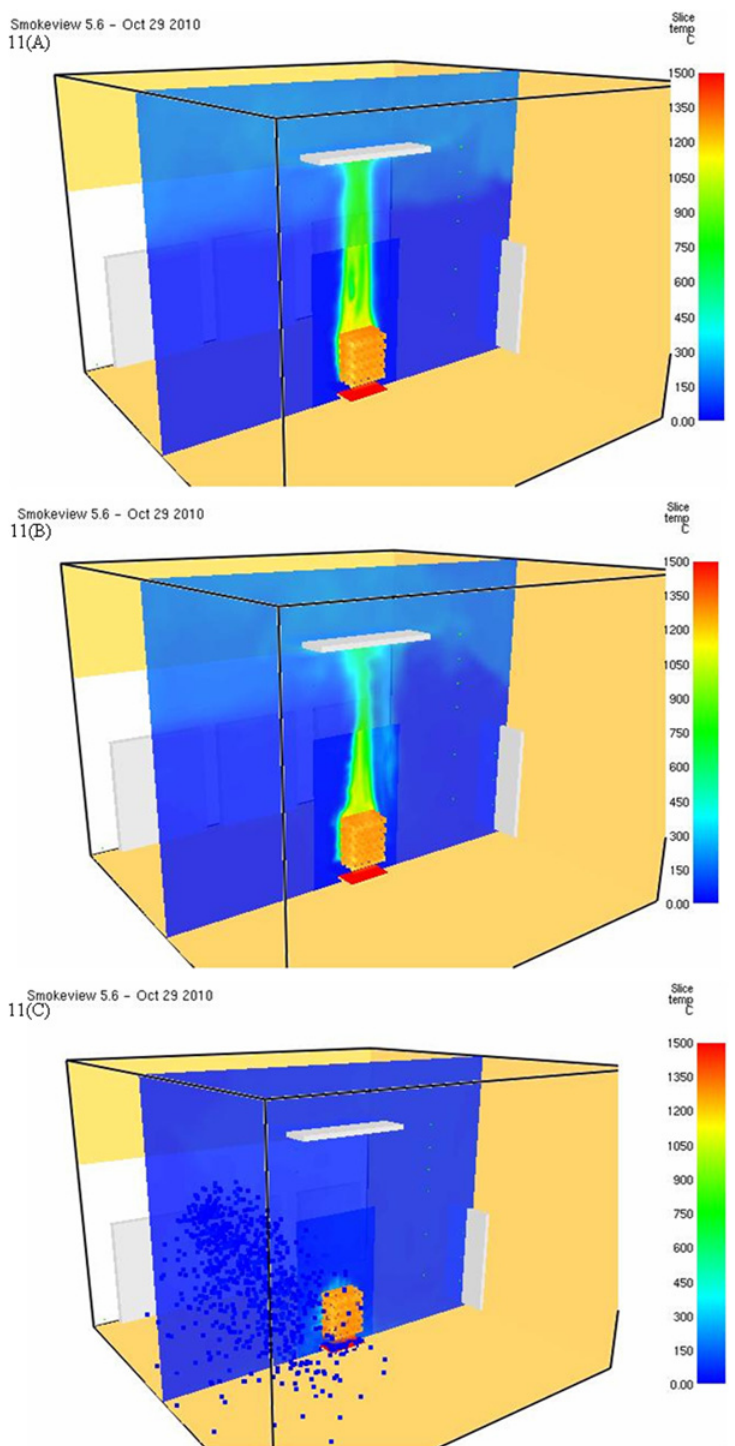
Fig 11. A: Temperature distribution of simulation results(Case FDS 5@180 s). B: Temperature distribution of simulation results(Case FDS 5 spk-n @180 s). C: Temperature distribution of Simulation results(Case FDS 5 spk @180